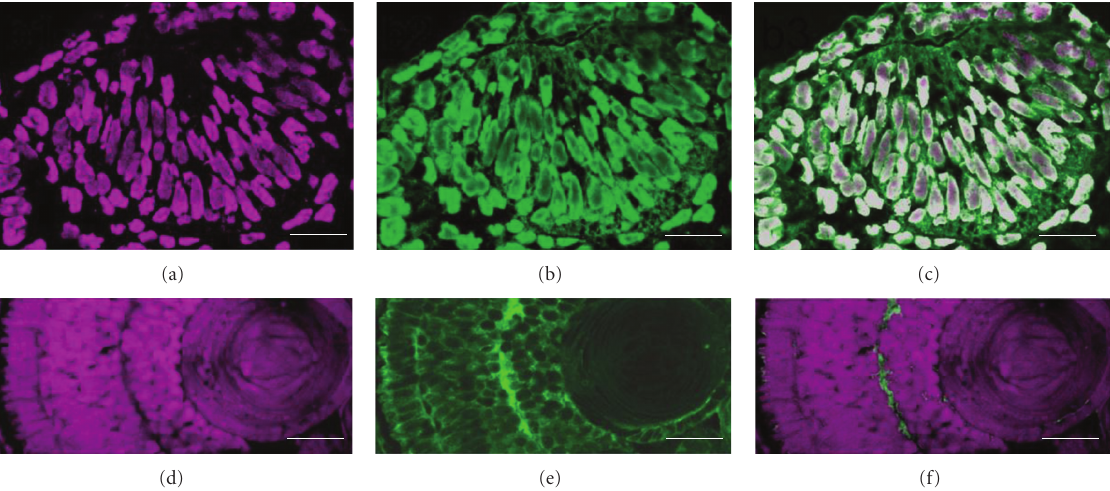
Figure 2: Double staining experiment of a developing retina at stage 28 (a–c) and stage 42 (d–f). Cell nuclei (a and d), the immunoreactivity for the HN1 protein (b and e), and the composite image (c and f). All scale bars indicate 50 μ m.